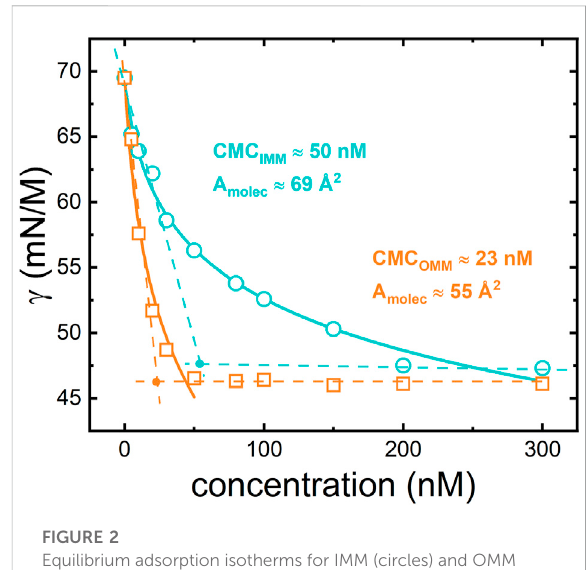
FIGURE 2 Equilibrium adsorption isotherms for IMM (circles) and OMM (squares) lipid extracts obtained from porcine heart. The experimental points are fi tted using the Langmuir-Gibbs equation (see Eq. 4 and text for